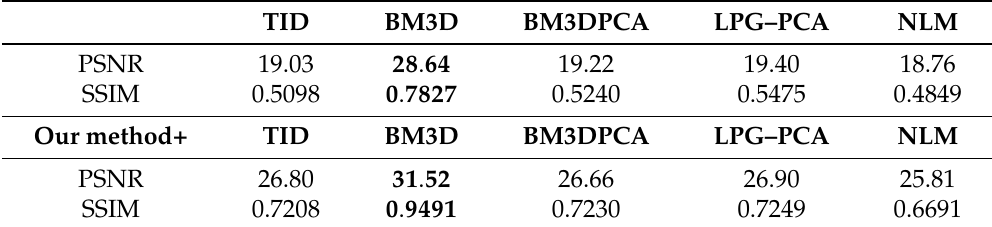
Table 2. Comparison of the average PSNR and SSIM with or without our method for the existing